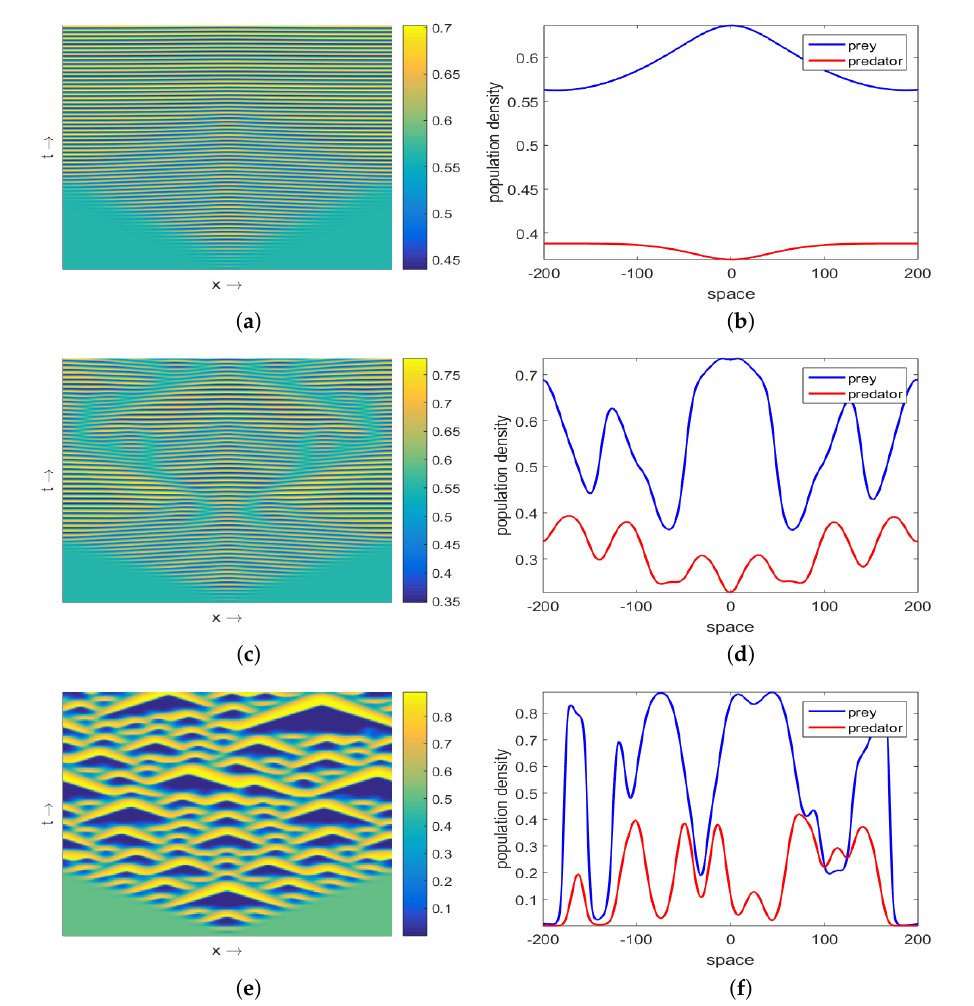
Figure 4. Spatiotemporal patterns (prey density) produced by the model (8)–(9) are presented in the left column for the parameter values as mentioned at the text and ( a ) β = 0.342; ( c ) β = 0.3445; ( e ) β = 0.36. Corresponding distribution of prey and predator population over space at t = 1000 are presented in the right column, see ( b ), ( d ), ( f